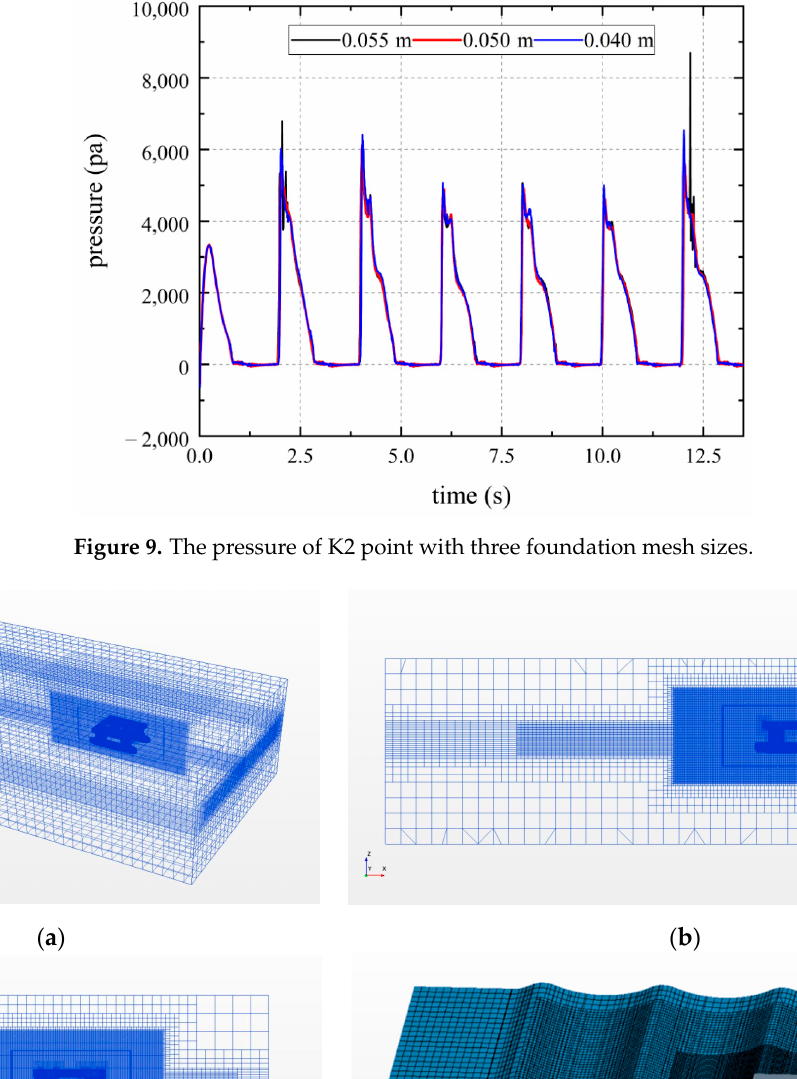
( b ) Figure 8. ( a ) Computational domain and boundary conditions; ( b ) The dimensions of the computational domain. 4.2. Grid Settings The semi-submersible platform was meshed using the overlapping mesh method in STARCCM+. Because the density and size of the grid in the wavelength direction of the free liquid surface affect the wave-transfer attenuation and the grid in the vertical direction affects the vertical motion of the wave, a prismatic layer grid was used for the free liquid surface part, and a cut body grid was used for the rest. The dense region was divided into the following features: Firstly, Free liquid surface part: Because the most extensive wave disturbance and variation are at the free liquid surface, the pressure gradient and velocity gradient vary significantly. Therefore, it was refined in two layers—the first layer was located above and below the free liquid surface when the platform was in hydrostatic equilibrium, with 15 grids in one wave height direction and 80–100 grids in one wavelength direction for a refinement height of three times the wave height. The second layer is refined to a size of 4–5 times the wave height with three times the number of grids as the first layer.Secondly, structural region of interest: The platform surface, spar, and floating tank surfaces and the nearby flow field were encrypted to reflect the wave–structure interactions and liquid surface changes accurately. Thirdly, to capture the overall platform motion, the possible range of platform motion must be encrypted. When calculating the pressure curves of K2 at the mesh size of 0.04 m, 0.05 m, and